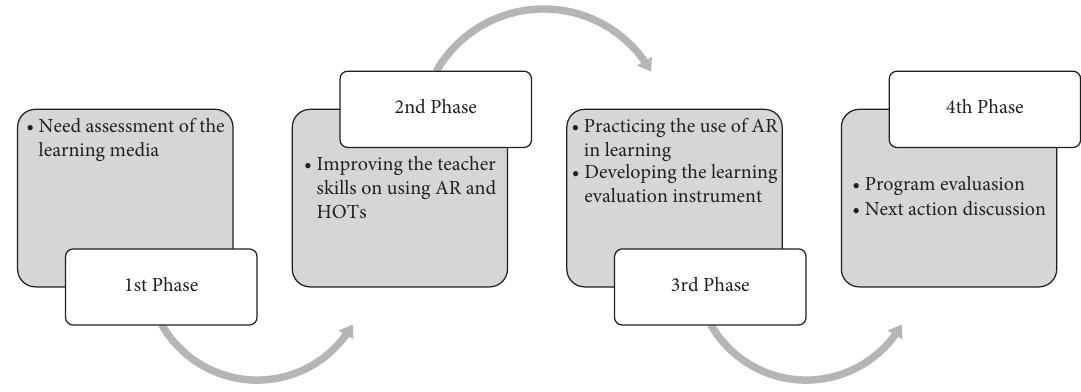
Figure 1: Stages of program